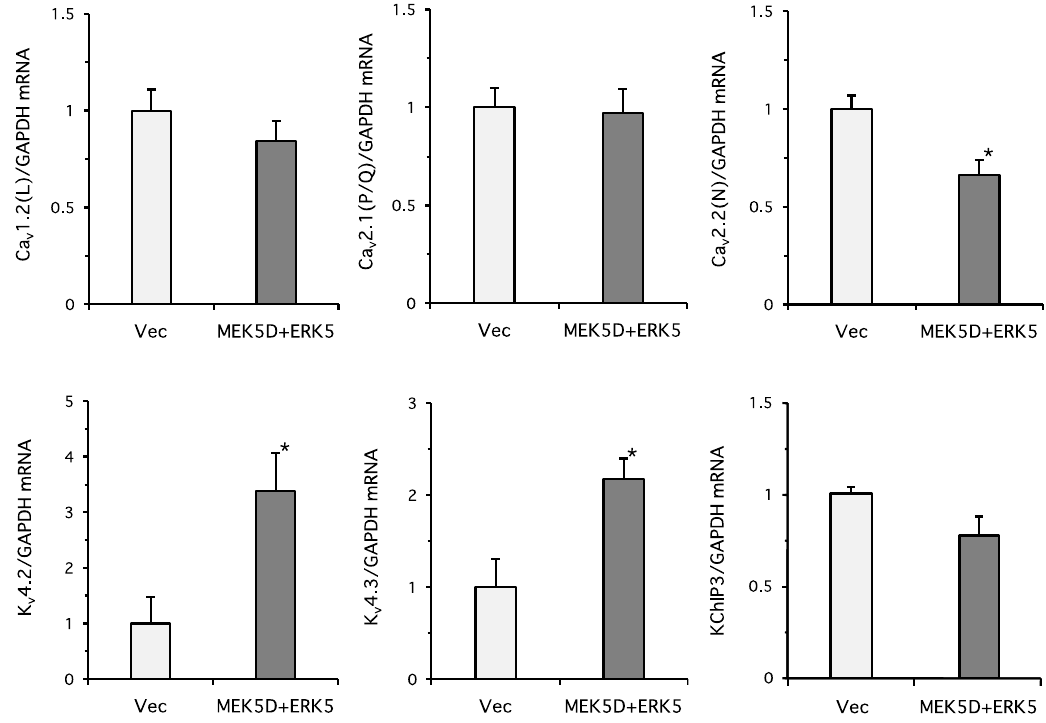
Figure 2. ERK5 promotes gene expression of K v 4.2 and K v 4.3 in PC12 cells. PC12 cells were transfected with empty vector (Vec) or MEK5 and ERK5. Two days after transfection, the total RNA was isolated from the cell lysates and RT-qPCR was performed using specific primers for Ca v 1.2, Ca v 2.1, Ca v 2.2, K v 4.2, K v 4.3, and KChIP3. ERK5 significantly promoted the gene expression of K v 4.2 and K v 4.3, and attenuated Ca v 2.2 expression (two independent experiments in triplicate ( n = 6), * p <0.05, unpaired Student’s t -test).